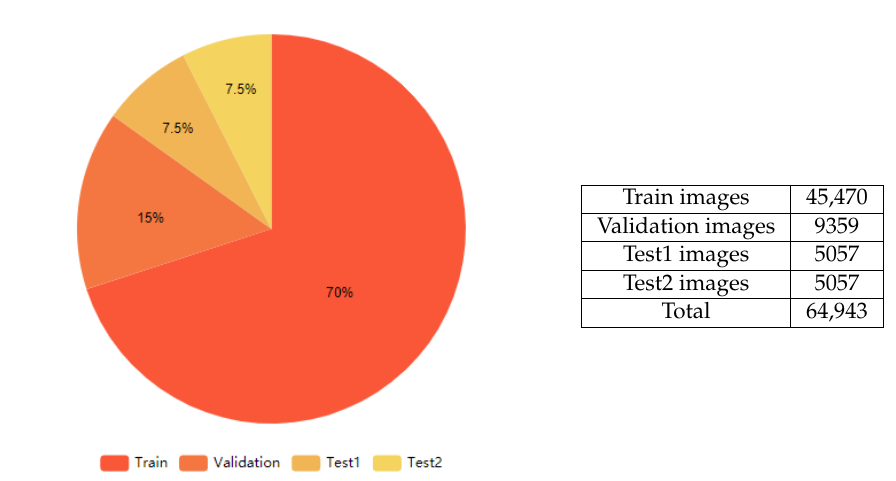
Figure 3. Training, validation and testing dataset. The dataset was split into three datasets as follows: Training (70%), Validation (15%), and Testing (15%). The test dataset was equally split into two sub-datasets (7.5% each): the first dataset was named Test1 and consisted of words that did not exist in